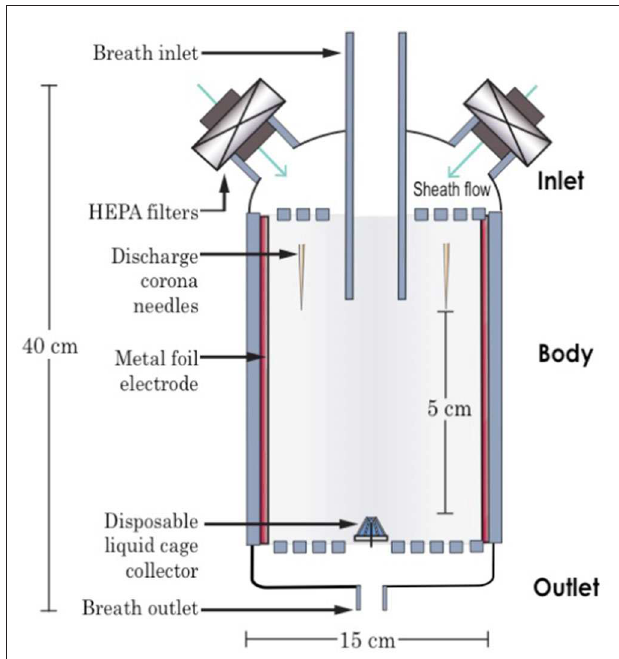
FIGURE 2 | Cross-sectional schematic of the breath electrostatic sampler (BESS). The device consists of a breath inlet, breath outlet, and a body housing a multi-point-to-plane electrostatic precipitator, along with a disposable liquid